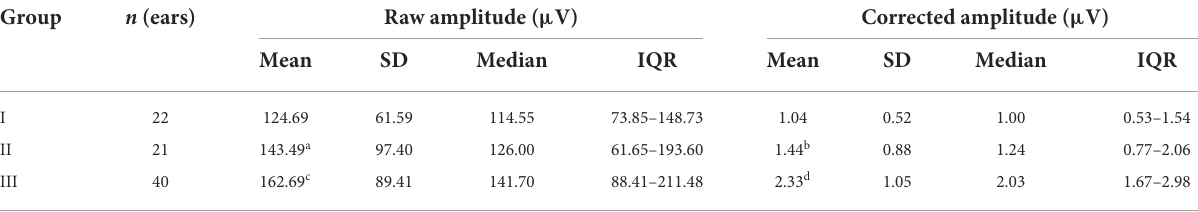
GroupI:Normalhearingearsfrominfants;GroupII:Sensorineuralhearinglossearsfrominfants;GroupIII:NormalHearingearsfromadults. n = numberofears. a,b,c,d Mann-WhitneyU-testwasusedtocomparetherawandcorrectedamplitudesofBCV-cVEMPbetweenGroupIandII,andbetweenGroupIandIII.